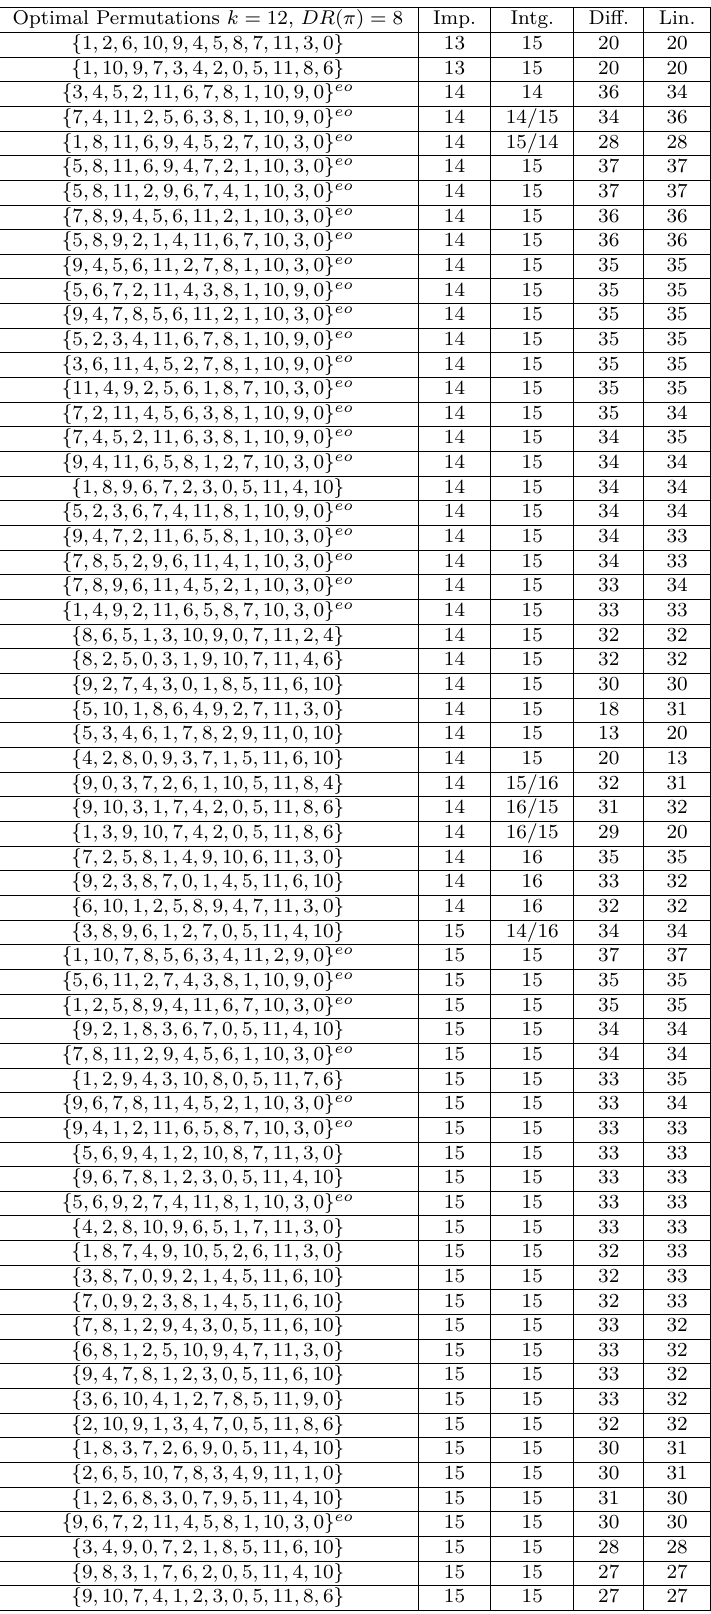
Table 13: Optimal permutations for k = 12 up to extended pair-equivalence Optimal Permutations k = 12, DR ( π ) = 8